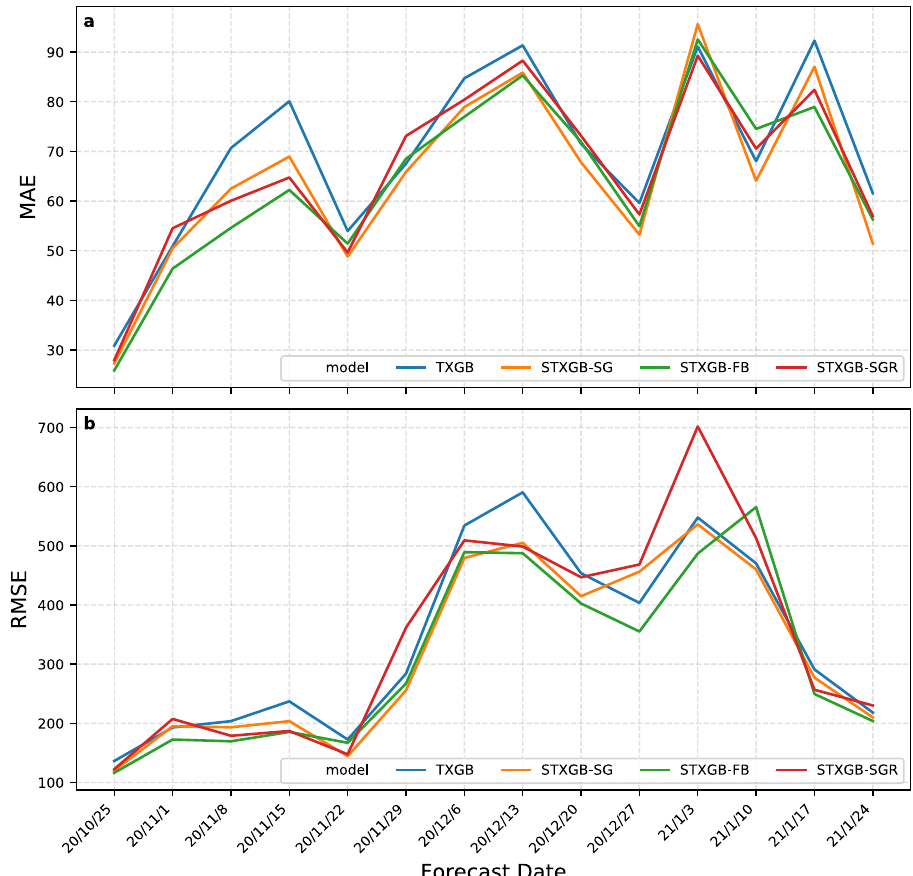
Fig. 1 Prediction errors of the SpatioTemporal eXtreme Gradient Boosting (STXGB) models in one-week prediction horizon against a temporal autoregressive model without spatial lags (TXGB). a Prediction MAE and b prediction R M S E of one-week ahead predictions of total new cases. STXGB- FB, which incorporates Facebook-derived features, including spatial lags based on Social Connectedness Index as well as Facebook-measured movement data, outperforms other models on average as indicated in Table